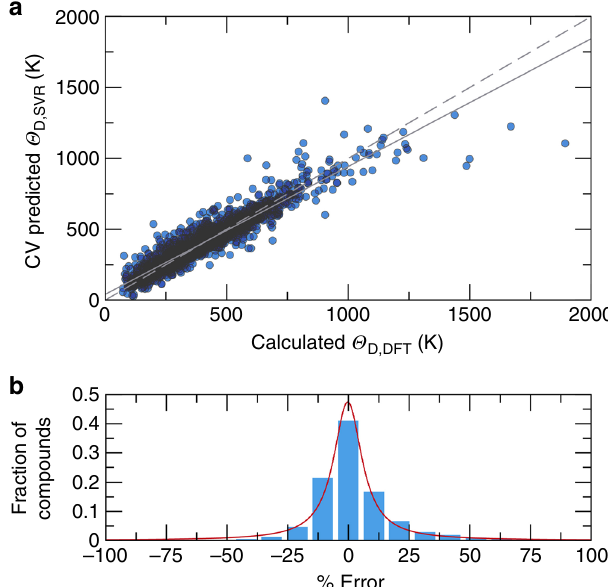
Fig. 1 Cross-validation plots for the machine-learning model predicting Debye temperatures. a Ten-fold cross-validation (CV) predicted Debye temperature ( Θ D,SVR ) versus calculated Debye temperature ( Θ D,DFT ). The ideal line is shown as dashed line and the fi t line is shown as solid line. b Fraction of compounds according to their percent error between CV predicted Θ D,SVR and Θ D,DFT . The red curve shows the trend